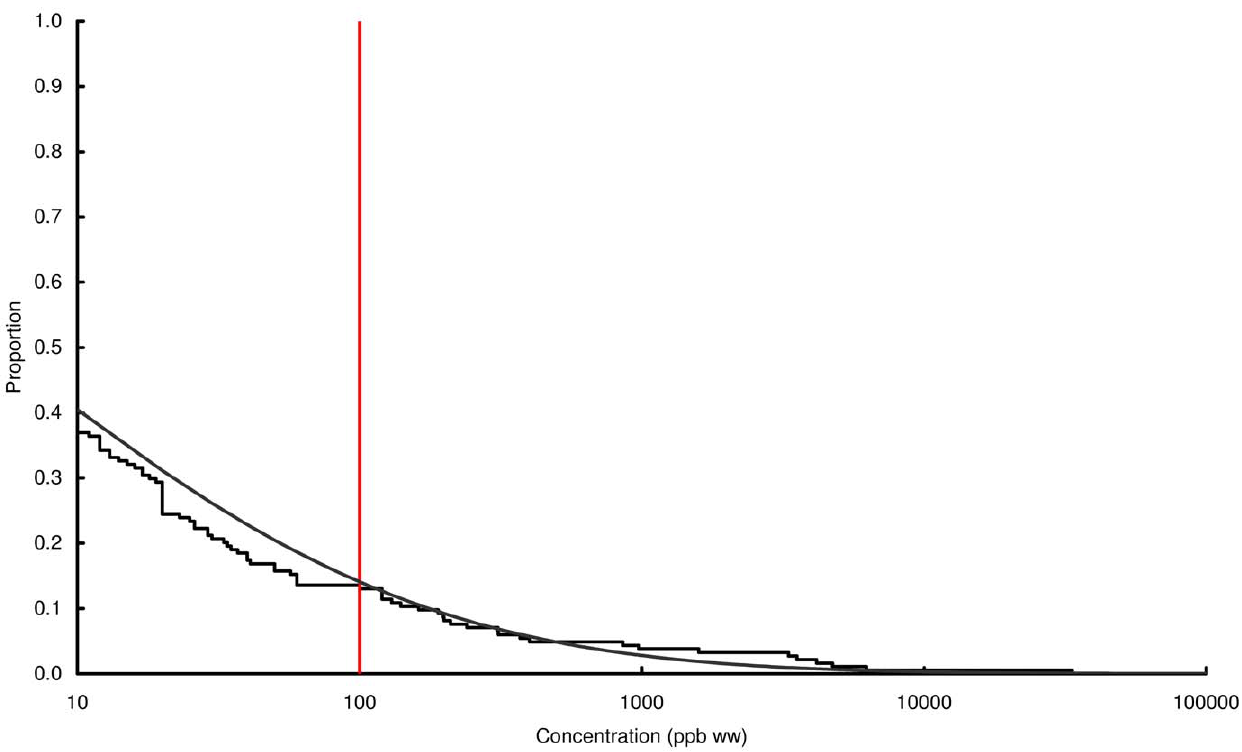
Figure 9. Exceedance distribution of lead concentrations in wild deer from the VMD statutory surveillance programme. Observed (stepped line) and fitted (curve) exceedance distribution of lead concentrations (ppb wet weight) in fresh uncooked venison tissue from wild deer from the VMD statutory surveillance programme. The curves represent lognormal distributions fitted to all the data, including those below the limit of quantification, by a maximum-likelihood method involving left-censoring at the LOD/LOQ. The red vertical line shows the statutory maximum residue level (MRL) for poultry and other non-game meat.